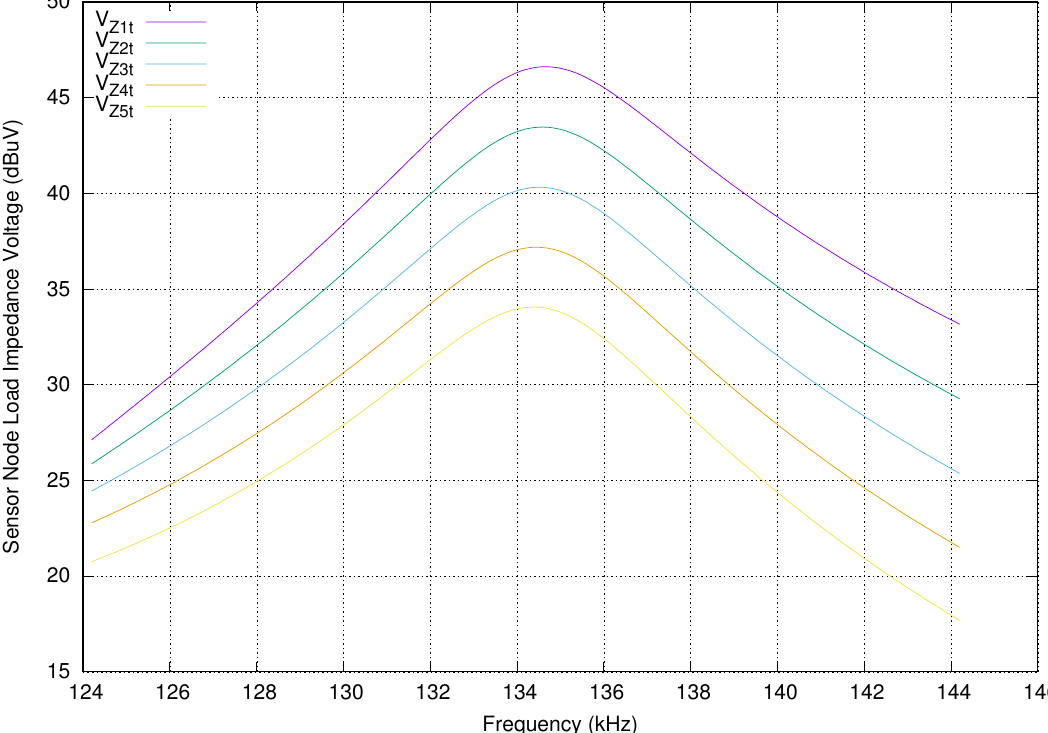
Figure 7. Sensor node load voltage in terms of frequency response when all sensor nodes are